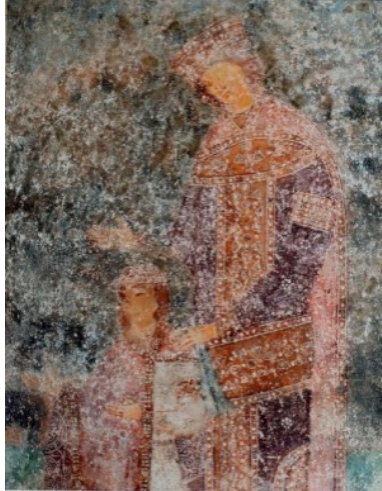
Figure 1. Queen Helen with Prince Stefan Uroš II Milutin, fresco, 1263–1268, Holy Trinity Church of Sopo ć ani Monastery, southeast corner of the narthex, first zone. Photo by Sr đ an Vulovi ć , courtesy of the National Museum of Kraljevo.